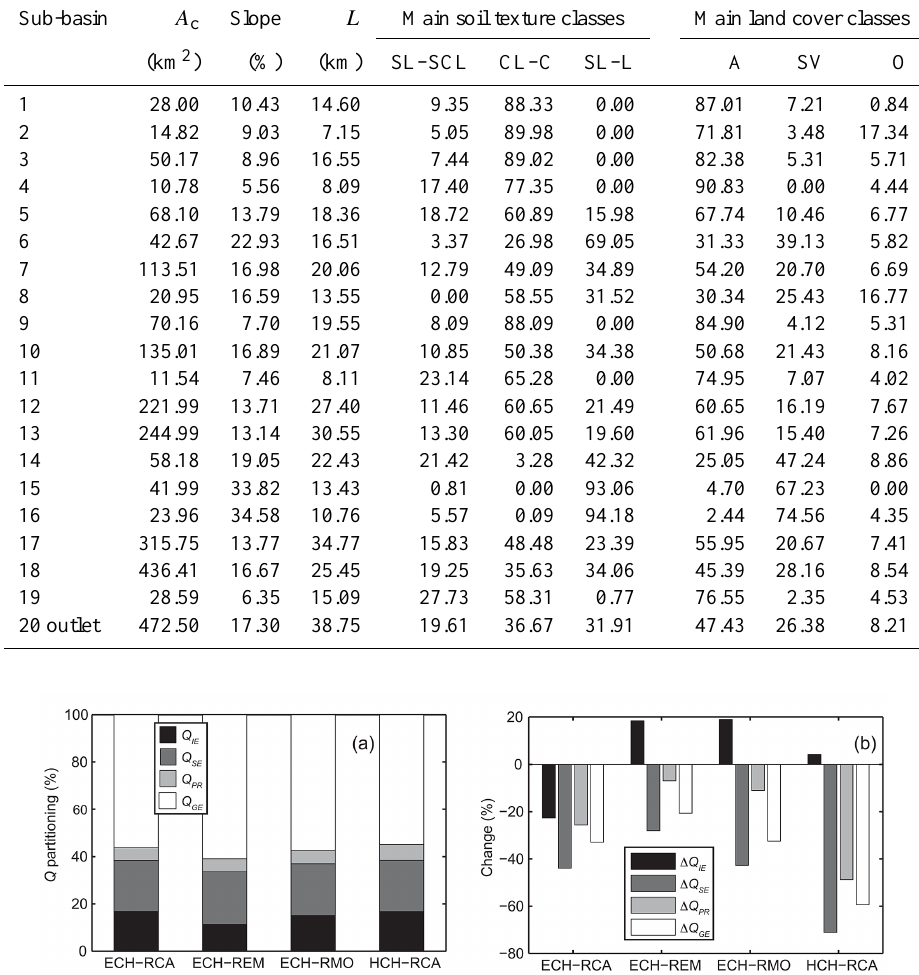
Table 3. Terrain, soil texture and land cover characteristics of the RMB sub-basins shown in Fig. 2b, including: contributing area ( A c ), slope, and length of the main channel ( L ); percentages of sandy loam–sandy clay loam (SL–SCL), clay loam–clay (CL–C), sandy loam–loam (SL–L); and percentages of agriculture (A), sparse vegetation (SV), and olives (O). Sub-basin A c Slope L Main soil texture classes